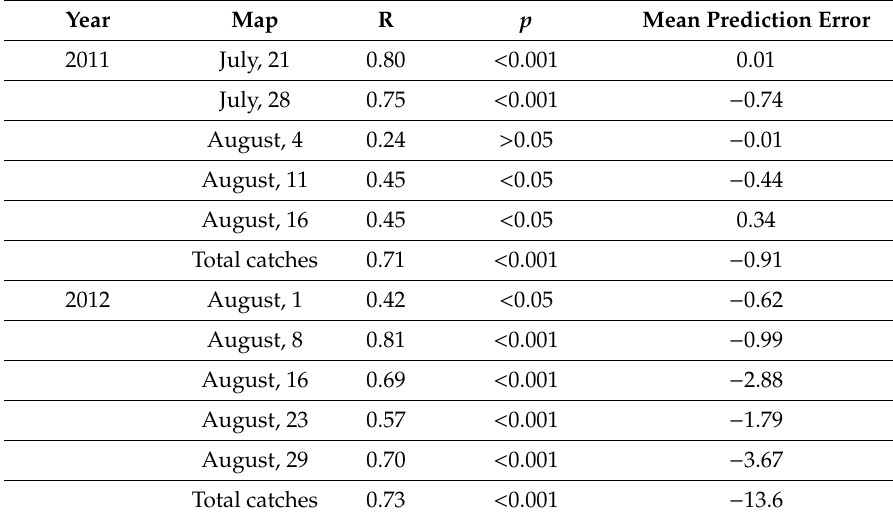
Table 3. Results of the cross-validation analysis of the inverse distance weighting (IDW) maps. The linear correlation of the predicted against measured values are reported.